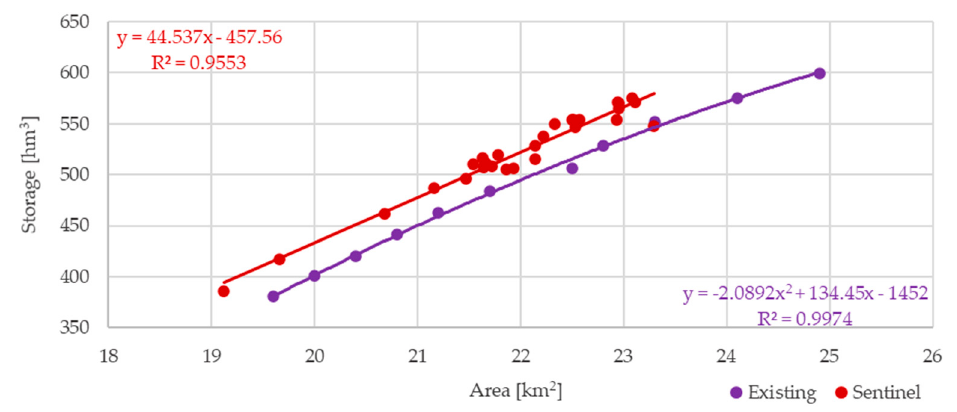
Figure 14. Estimated area and observed storage relationship compared to an existing relationship [42].